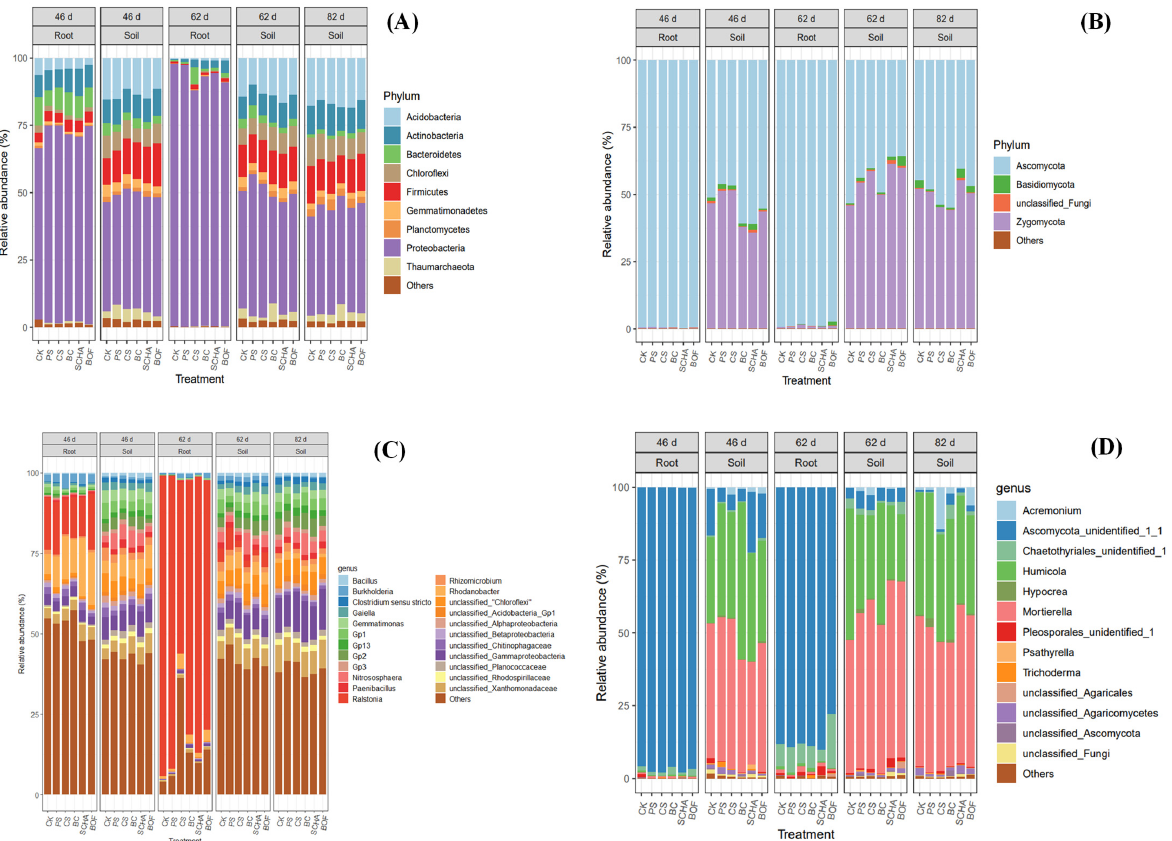
Figure 6. Relative abundance at the bacterial phylum level ( A ), bacterial genus level ( B ), fungal phylum level ( C ), and fungal genus level ( D ) among the different treatments ( n = 4). Amendment treatments include CK (no fertilization); PS (potassium silicate); CS (calcium silicate); BC (biochar); SCHA (calcium silicate humic acid); BOF (bio-organic fertilizer).